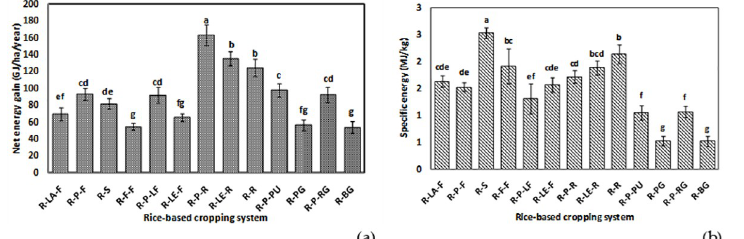
Fig 4. Net energy gain (GJha − 1 year − 1 ) (a) and specific energy (MJkg − 1 ) (b) of different rice-based cropping systems